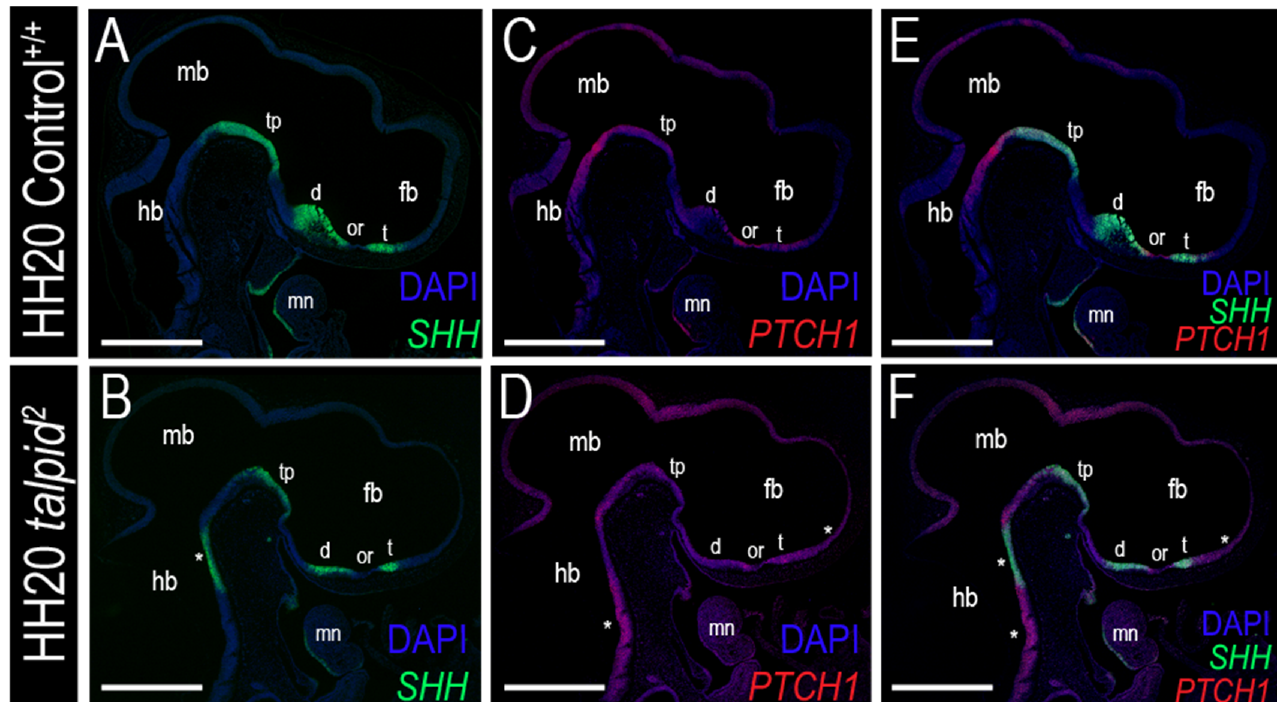
Figure 5. Expanded FEZ correlates with increased PTCH1 expression. ( A – F ) RNAscope in situ hybridization for ( A , B ) SHH , ( C , D ) PTCH1 or ( E , F ) both SHH and PTCH1 in HH20 control +/+ and ta 2 brain and craniofacial complex. Asterisks (*) denote ectopic expression of ( B ) SHH , ( D ) PTCH1 , or ( F ) both SHH and PTCH1 in the developing ta 2 brain and craniofacial complex. d: diencephalon, fb: forebrain, hb: hindbrain, mb: midbrain, mn: mandibular arch, or: optic recess, t: telencephalon, tp: tuberculum posterius. Scale bars: ( A – F ) 500 μ m.